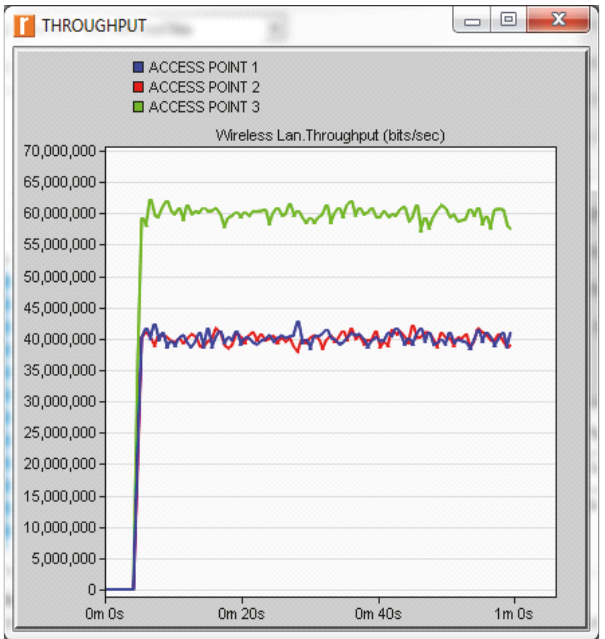
Figure 3: WLAN throughput of different access points.